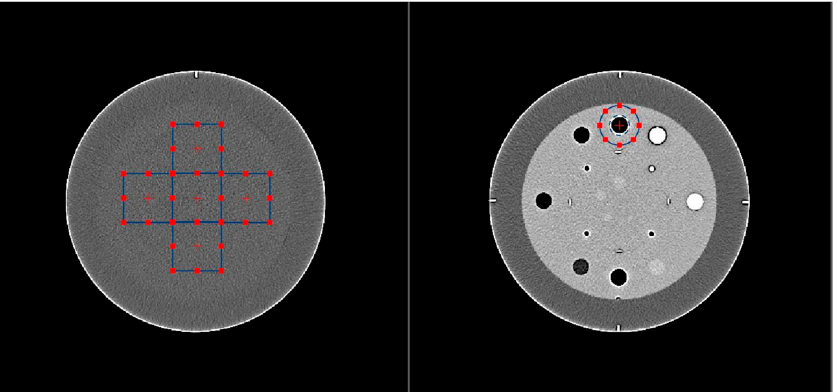
Figure 1. Visualization of the two relevant modules of the CATPHAN phantom and imQuest ROI for physical metrics evaluation. The left picture shows the homogeneous module, and the right picture is the module with the inserts.